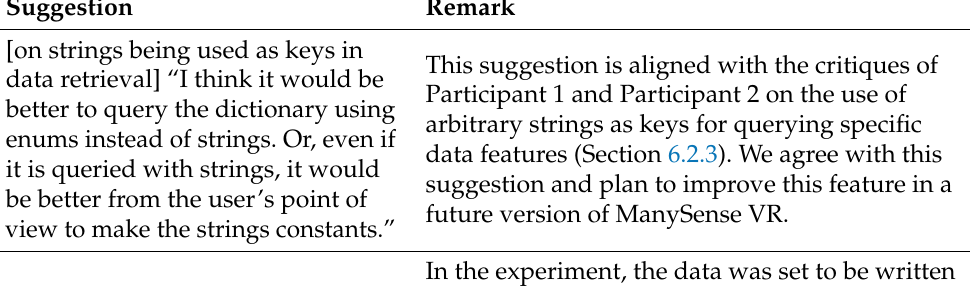
Table 4. Improvement suggestions from Participant